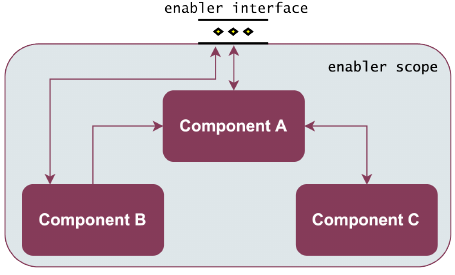
Figure 9. General enabler design